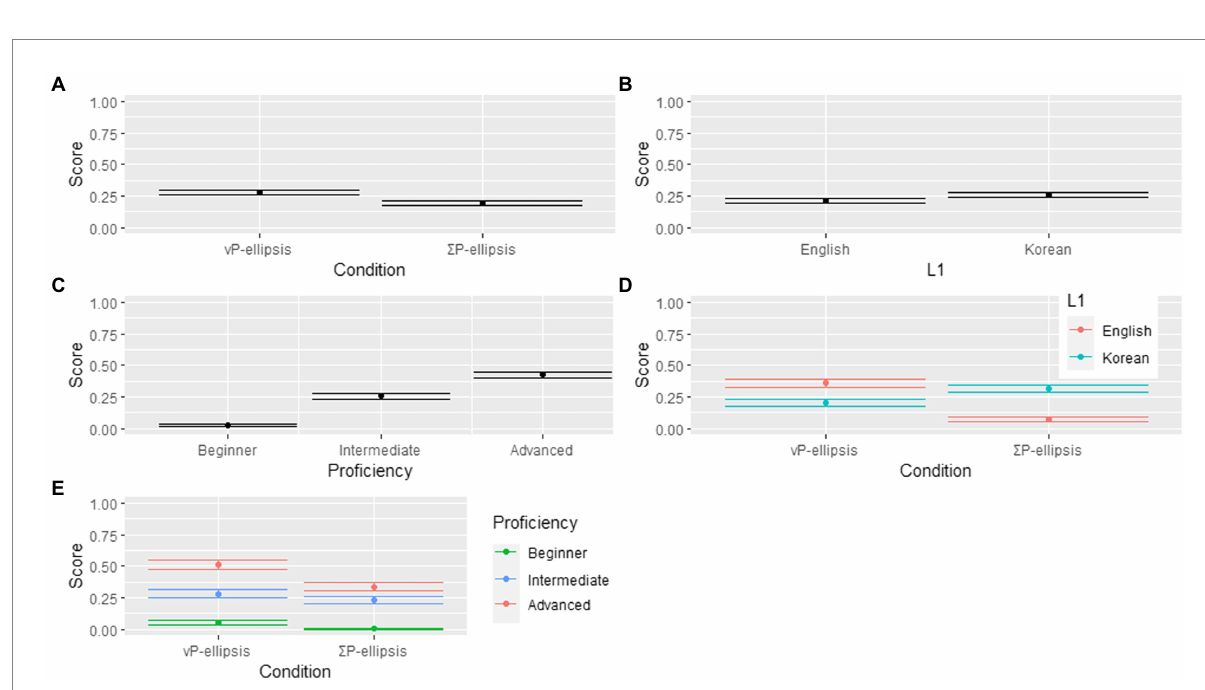
FIGURE 4 Score as a function of Condition, Proficiency, and L1. (A) Score as a function of Condition. (B) Score as a function of L1. (C) Score as a function of Proficiency. (D) Score as a function of Condition by L1. (E) Score as a function of Condition by